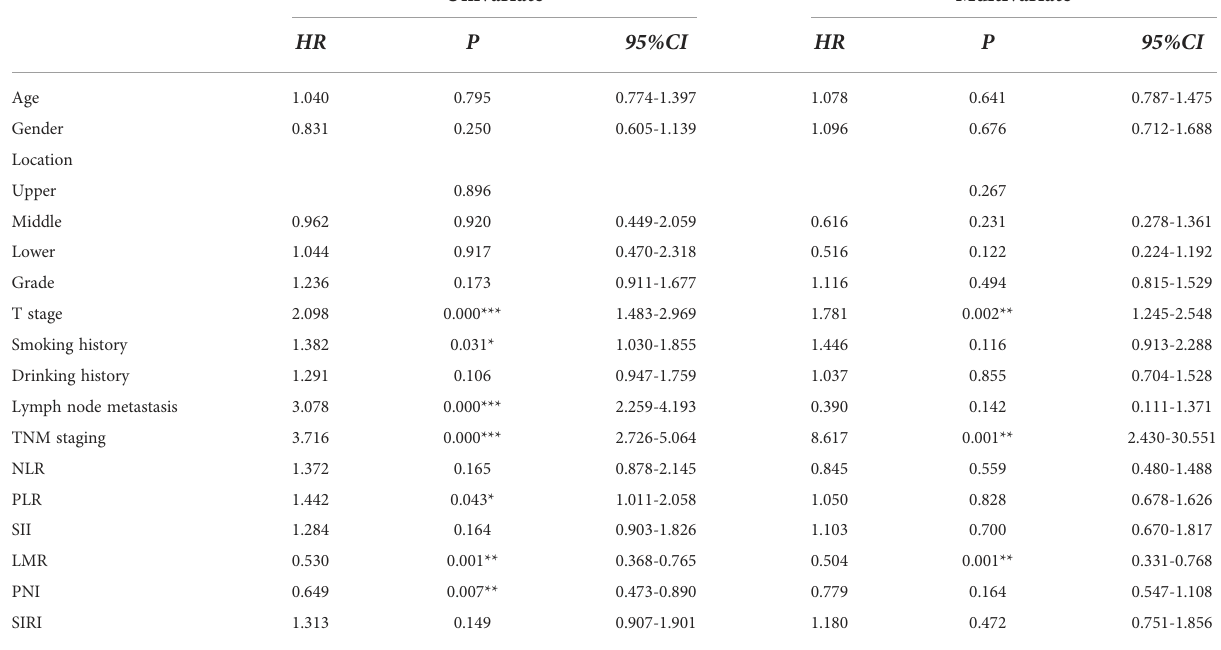
TABLE 3 The univariate and multivariate